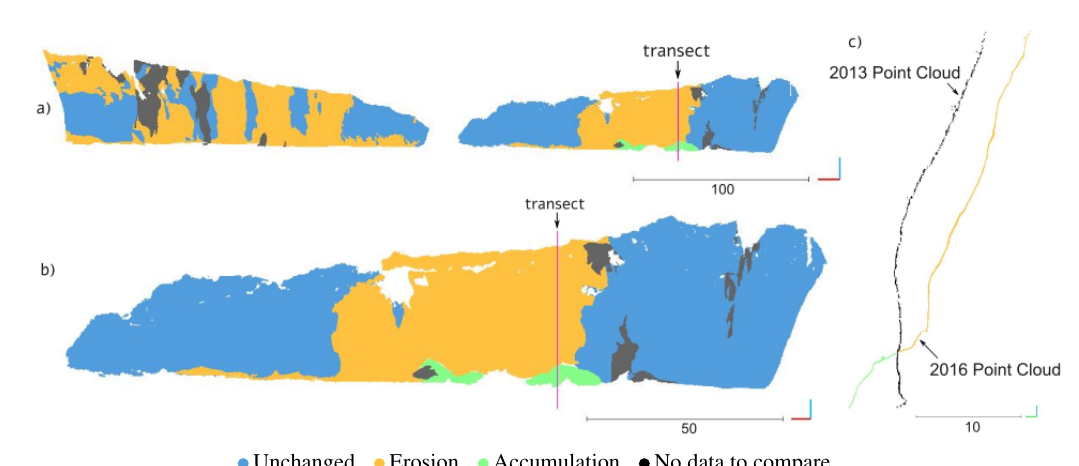
Figure 2. a) Annotation of the PC from 2016-01-28 with the PC from 2013-09-25, b) West part of Ailly cliff and transect position c) Transect showing erosion of the cliff with accumulation at the cliff base.